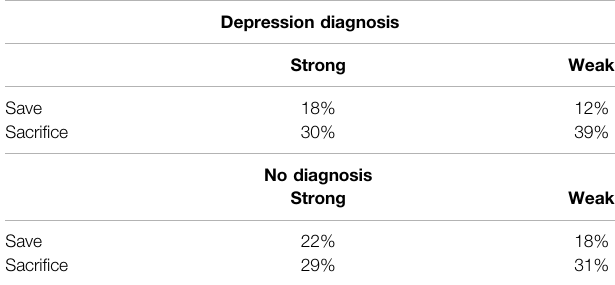
TABLE 7 | Relative frequency of initiating utterances made by depressed ( N (cid:1) 15) and non-depressed ( N (cid:1) 45) participants inrespect totheir strength (strongor weak) and content (sacri fi ce or save).